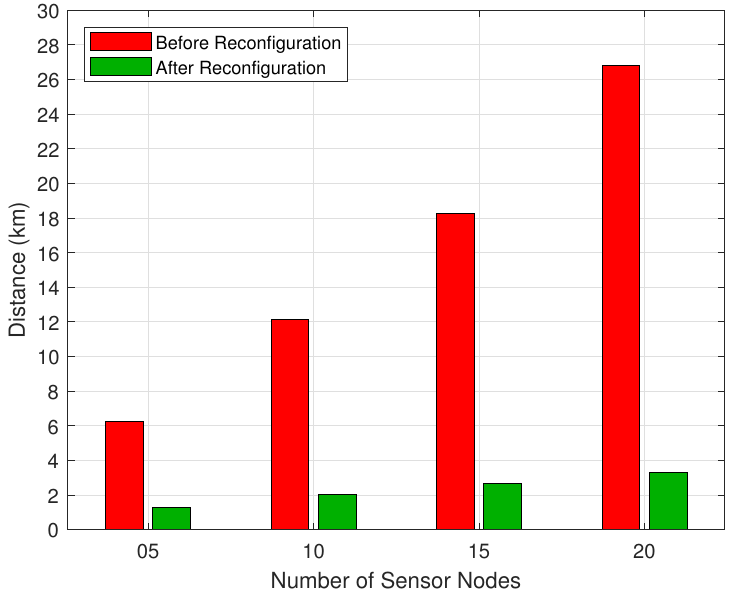
Figure 17. Flight distance during the reconfiguration phase.